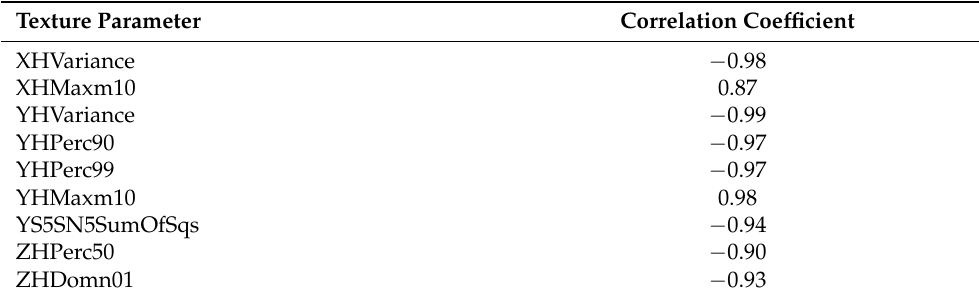
X—color channel X ; Y—color channel Y ; Z—color channel Z ; Maxm—maximum of moments; Perc—percentile; SumOfSqs—sum of squares;